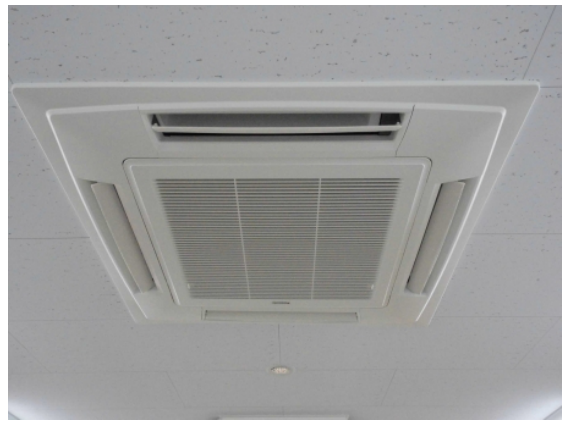
Figure 5. Example of the air conditioner under the